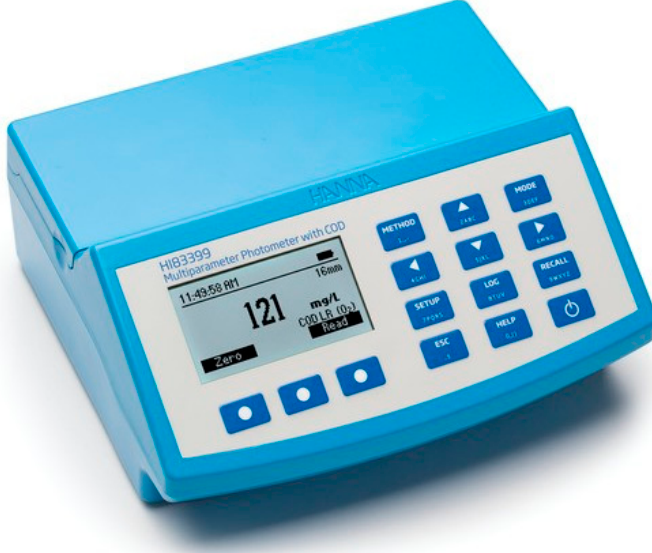
Figure 2. Multiparameter photometer used in the study.